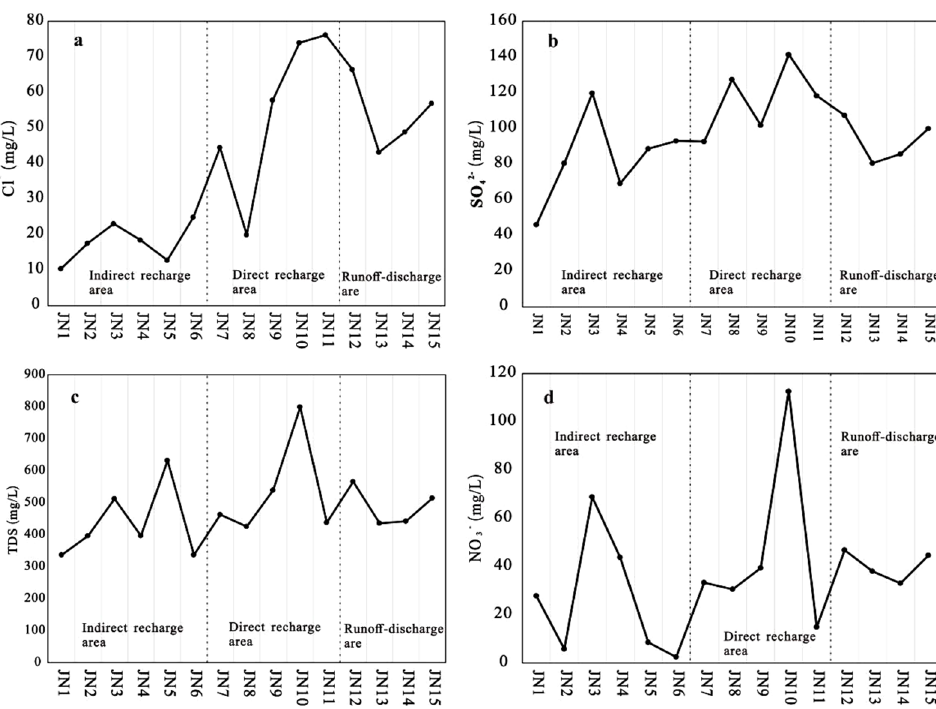
Figure 7. Variation of ion components (( a ) Cl − ; ( b ) SO 42 − ; ( c ) TDS; ( d ) NO 3 − ) in karst water along Flow Path I (south → north).